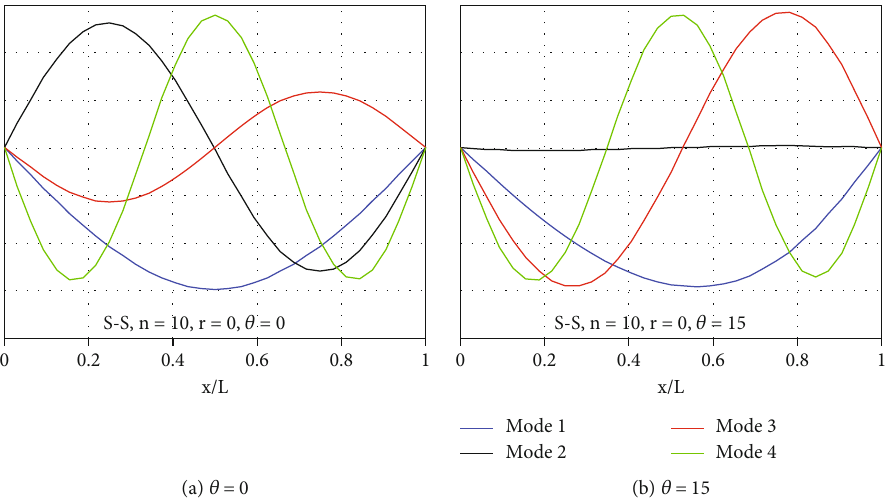
Figure 3: The subordination of the fi rst fi ve nondimensional frequencies of piezoelectric FG beam on the rotational speed, n = 0 : 5 , K ∗ and K ∗ s = 2